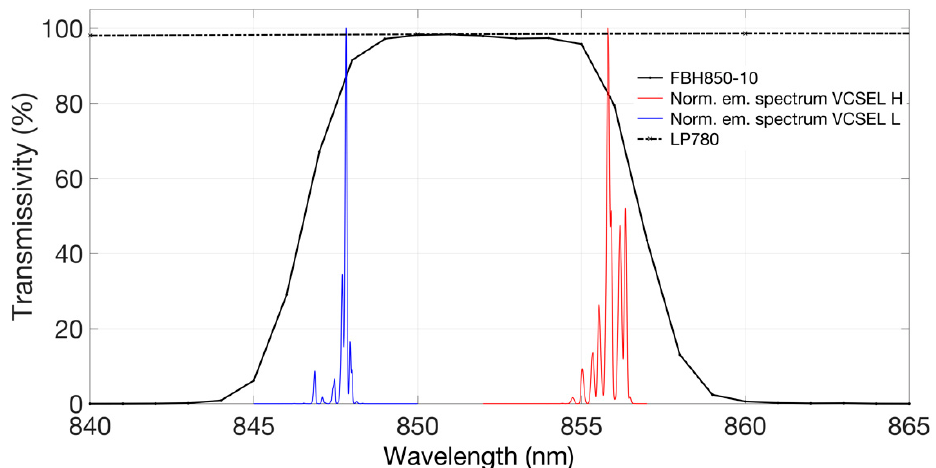
Figure 3. Comparison between the transmittivity spectrum of the optical filters (black traces) and the normalized emission spectra of two samples of the OPV 332 VCSELs, both driven at 11 mA. The red trace (VCSEL H) is the normalized emission spectrum of a VCSEL sample with the highest value of peak emission wavelength (among all the available VCSEL samples) whereas the blue trace refers to the normalized emission spectrum of the VCSEL sample with the lowest value of peak emission wavelength. Both spectra are contained within the transmission band of the narrow bandpass filter FBH-850-10. All the tested samples of OPV 332 VCSELs exhibited spectra with the emission peak falling inside the wavelength range from 847 up to 857 nm.